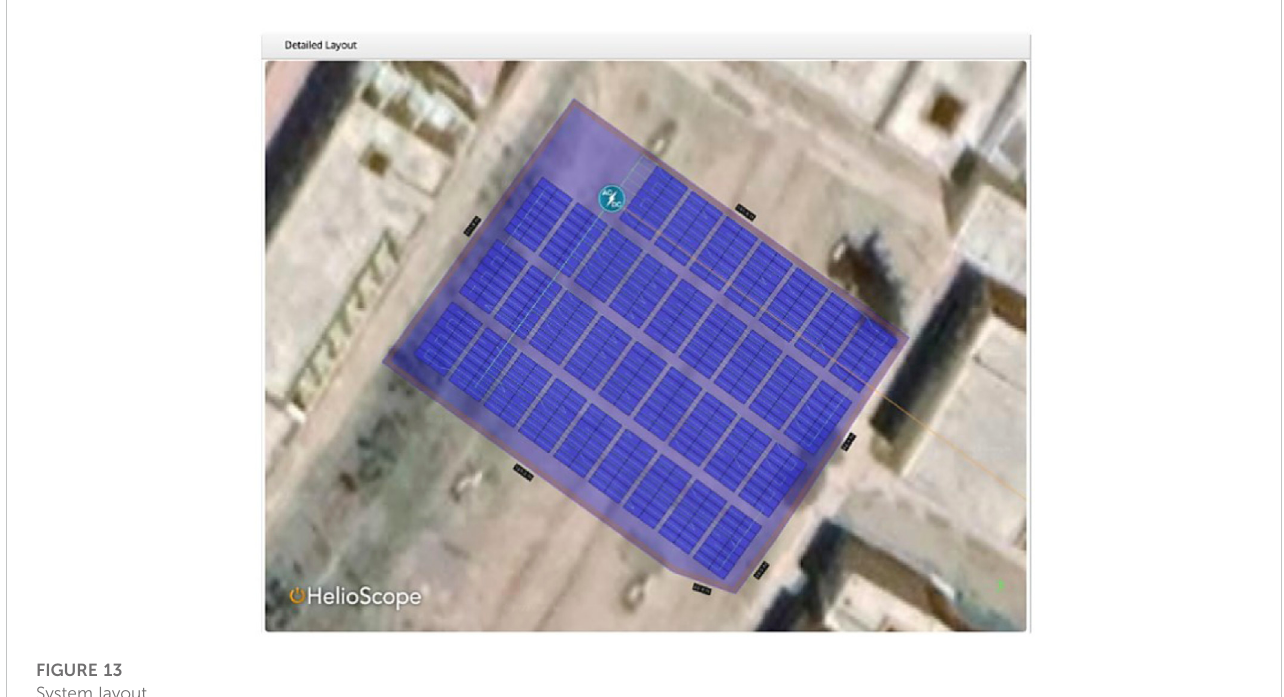
FIGURE 13 System